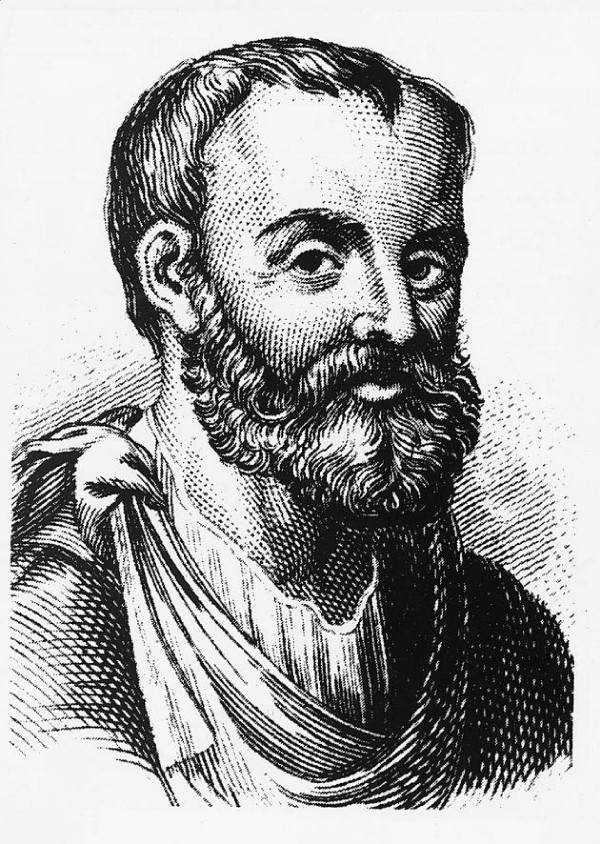
Galen of Pergamon.